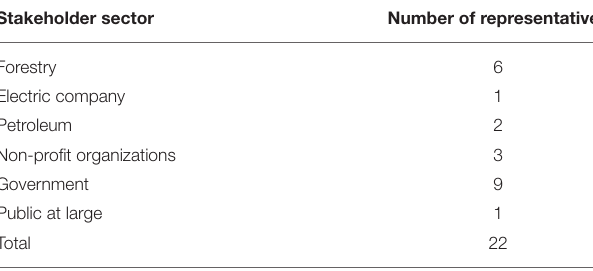
TABLE 1 | Northwest Grizzly Bear Team